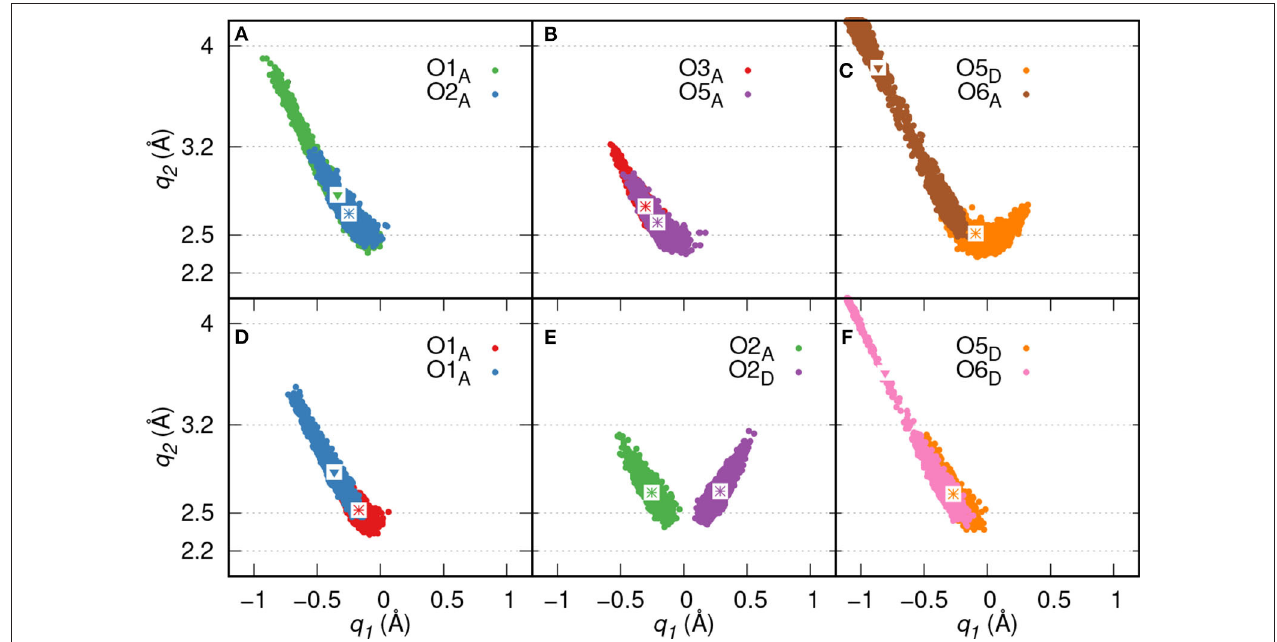
FIGURE 4 | HB correlation q 2 vs. q 1 of HBs formed between GP and water in GP’s M motif (A–C) and B motif (D–F) , respectively. The average q 1 and q 2 coordinate pairs are shown as points in white square boxes. A strong to moderately strong HB is denoted as * while a moderately strong HB and a moderately strong to weak HB are denoted as • and H , respectively.